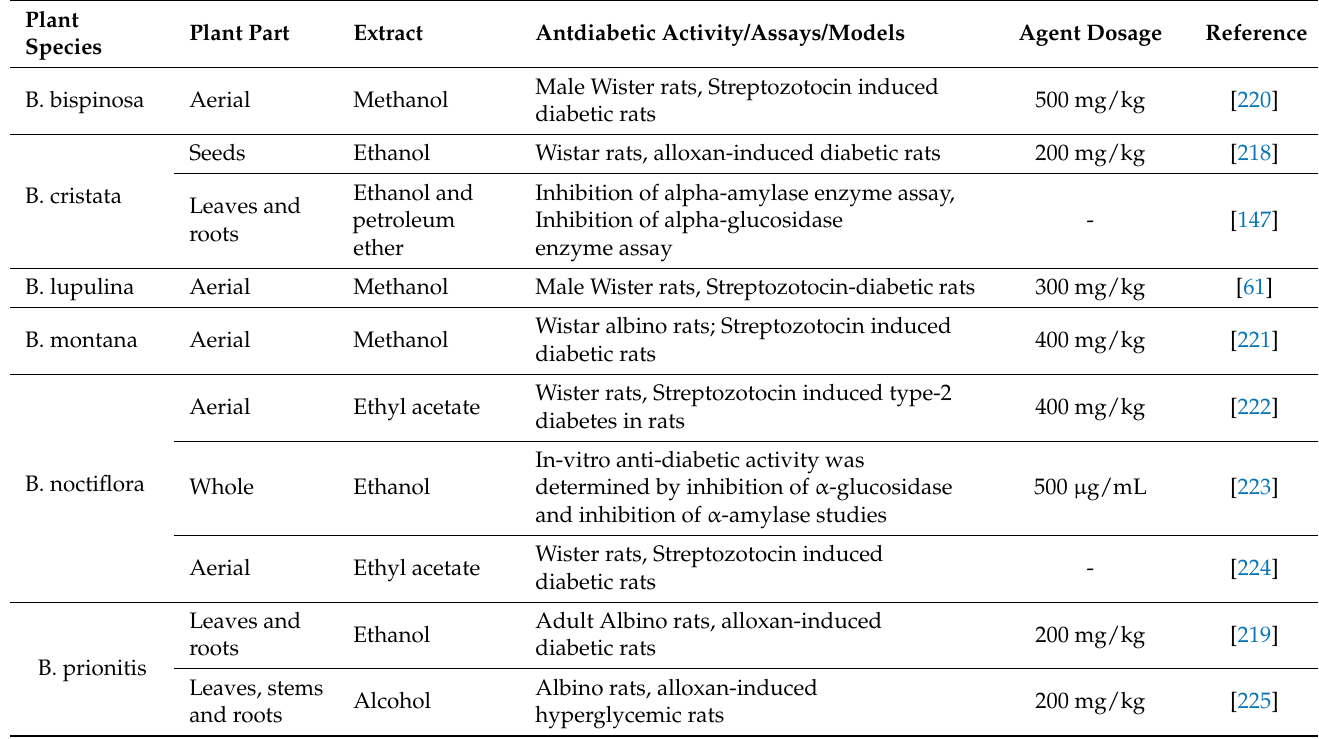
Table 7. Antidiabetic activities of extracts and fractions from species within Barleria